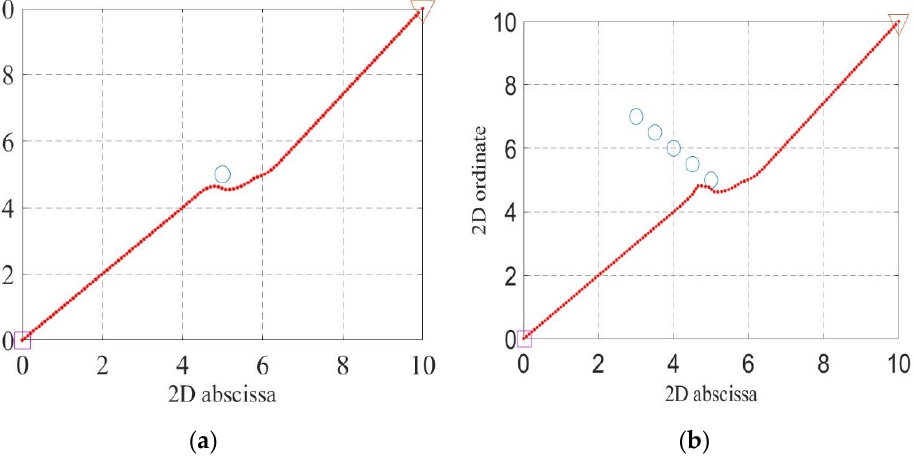
Figure 13. Simulation results when obstacles are in the middle: ( a ) Single obstacle; ( b ) Multiple obstacles.